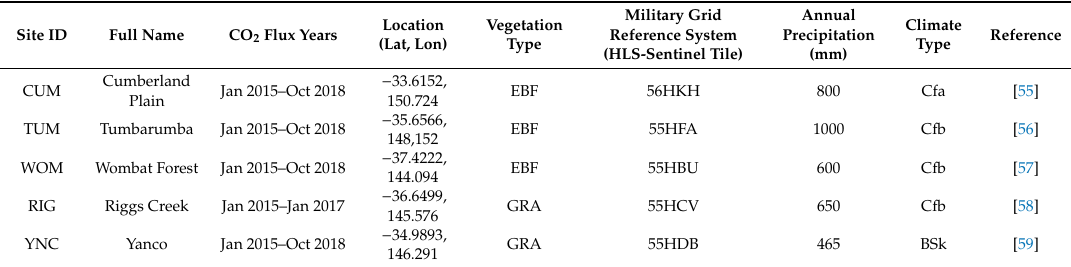
Table 1. Information on research sites. Climate types follow the Köppen classification system [54] (Cfa—warm temperate fully humid with hot summer, Cfb—warm temperate fully humid with warm summer, BSk—arid steppe cold). EBF and GRA in the vegetation type column represent evergreen broadleaf forest and grassland, respectively. ID—identifier; Jan—January; Oct—October; Lat—latitude; Lon—longitude; HLS—Harmonized Landsat and Sentinel-2